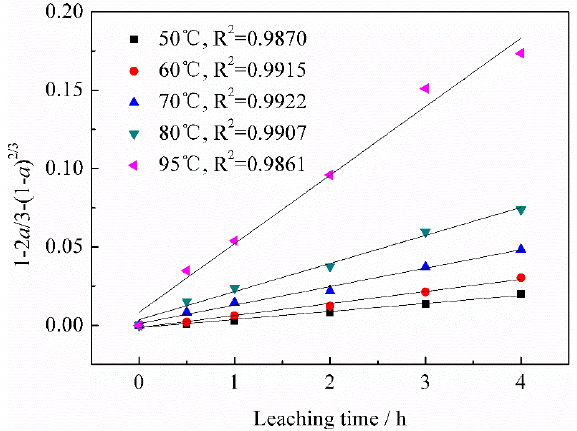
Figure 16. Fitting plots of 1 − 2 α /3 − (1 − α ) 2/3 versus leaching time t at different leaching temperatures.